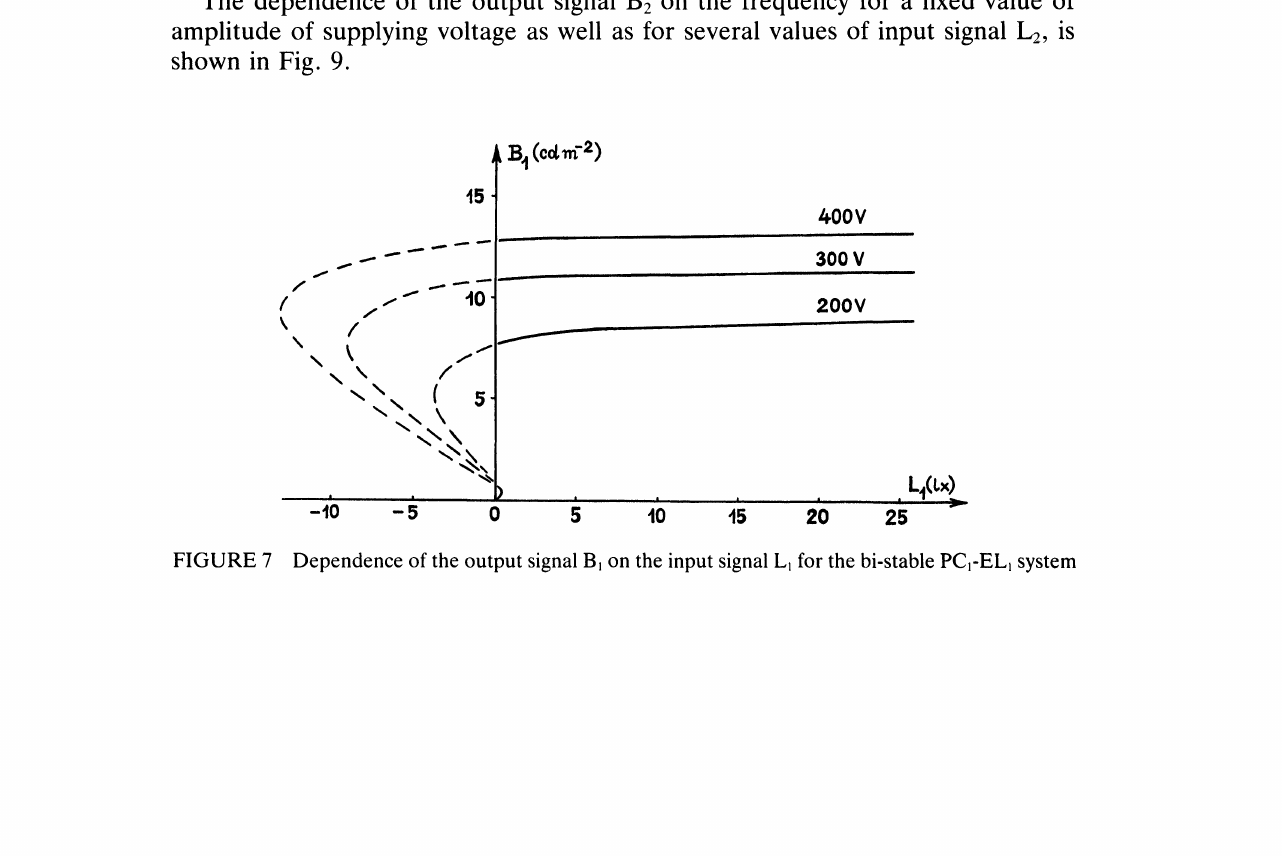
FIGURE 6 Dependence of the output signal B on the frequency of voltage supplying the PC1-EL1 system for various amplitudes of this voltage